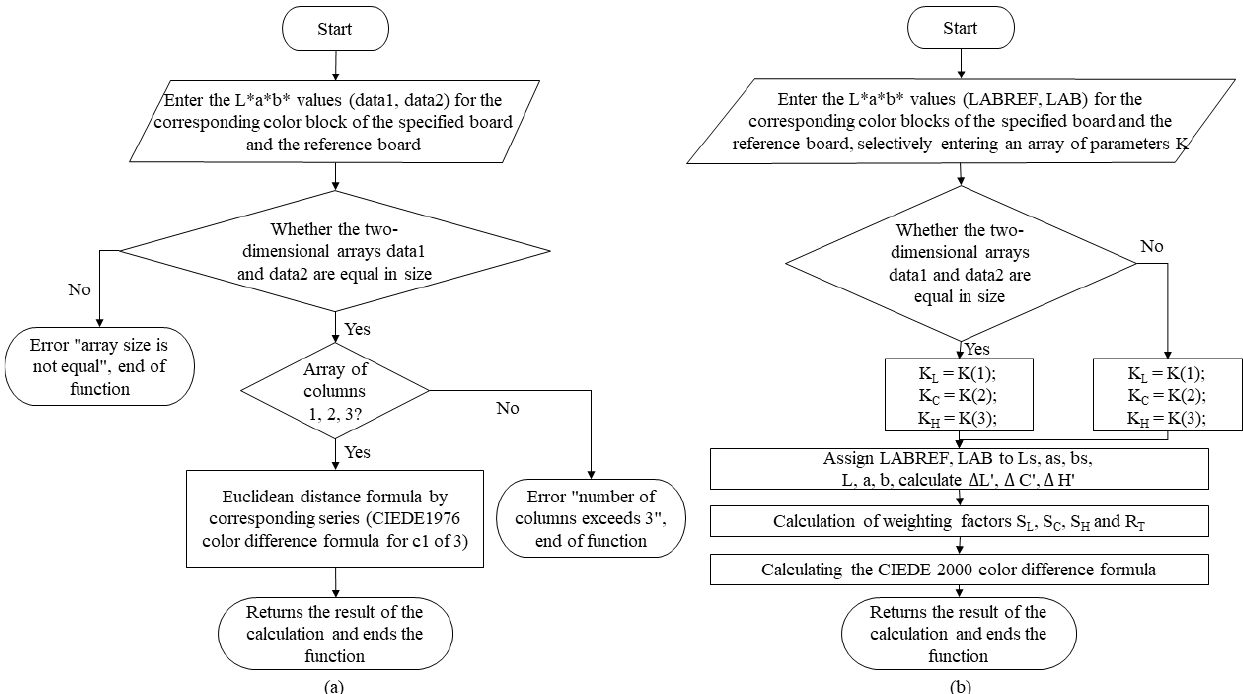
Figure 1. Compilation framework for color difference algorithms: ( a ) CIEDE1976 and ( b ) CIEDE2000.